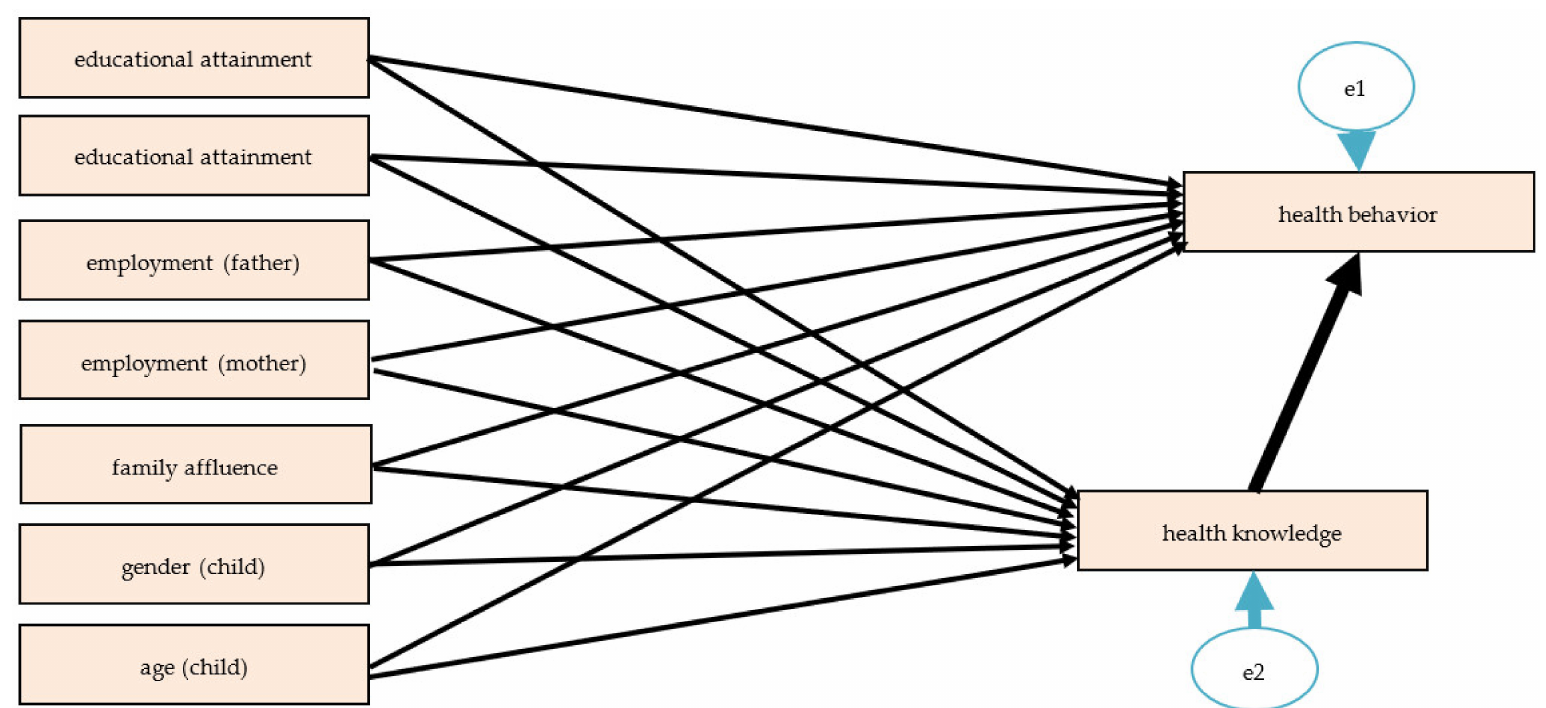
Figure 1. Path model of health-related knowledge and health behavior . Unanalyzed associations: all possible correlations between educational levels, employment, and family a ffl uence and correlations between family a ffl uence and gender (child), educational attainment (father) and gender (child), educational attainment (mother) and gender (child), and educational attainment (mother) and age